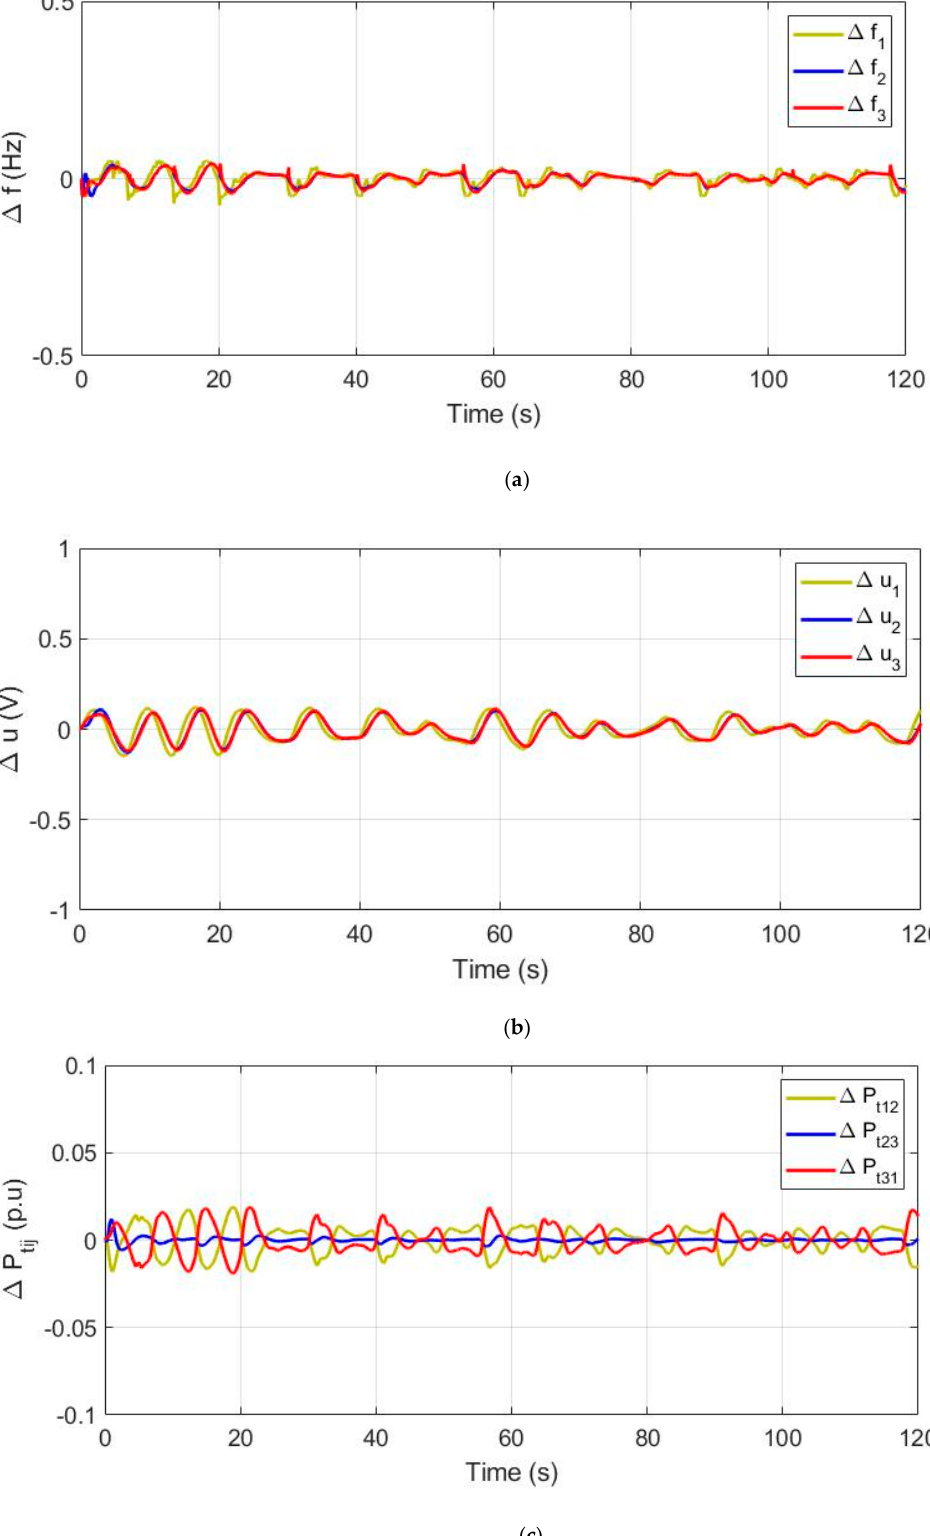
∆ u ∆ P i ), and ( c ) tij